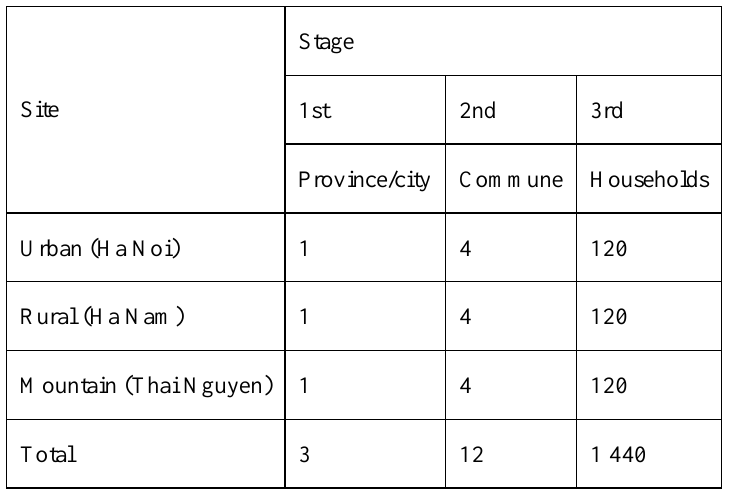
Table 1: Sample Design